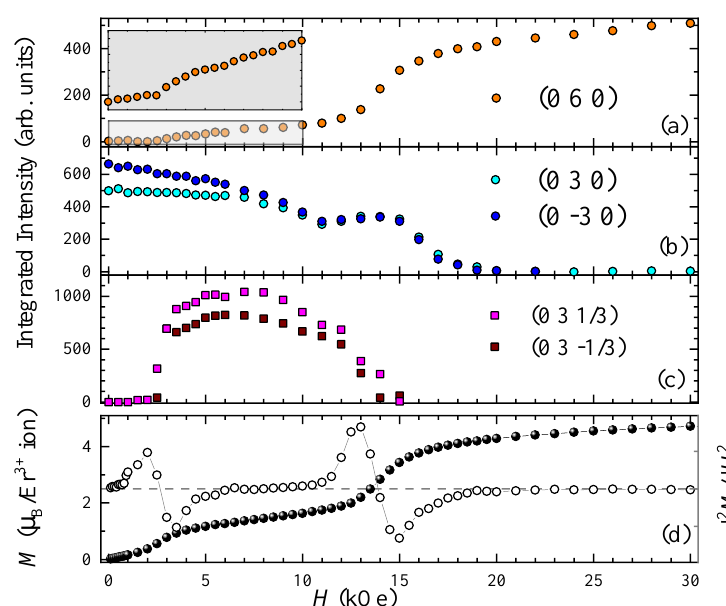
Figure 4: Integrated intensities recorded at T = 50 mK on the D10 diffractometer as a function of the magnetic field applied along the a axis for (a) the (060) reflection representing the ferromagnetic component, (b) the (0 ± 3 0) reflections characteristic of the zero-field antiferromagnetic structure and (c) the ( 03 ± 1 / 3 ) reflections repre- senting the modulated spin component of the UUD structure. The inset focuses on the low-field region emphasizing the field-induced phase transition at about 2.5 kOe by showing the data taken with higher density of points and longer monitor